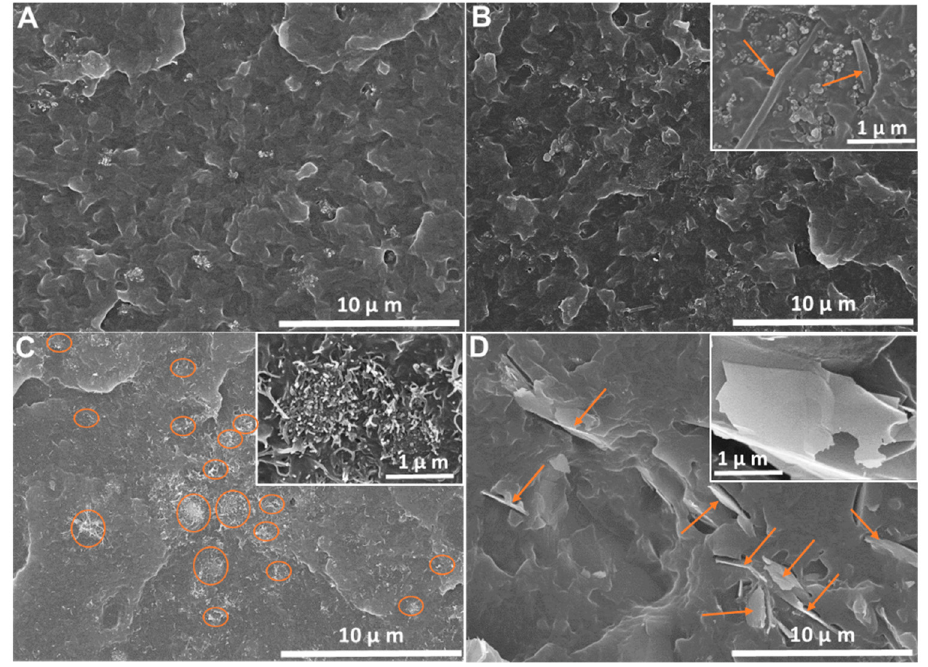
Figure 2. SEM images of ( A ) SEBS and its composites with 5 wt.% of ( B ) CNF, ( C ) CNT, and ( D ) graphene at 5000× magnification. The magnification of the insets in (B–D) is 50,000×. The dispersion of the different fillers within the SEBS matrix presented different features. CNF